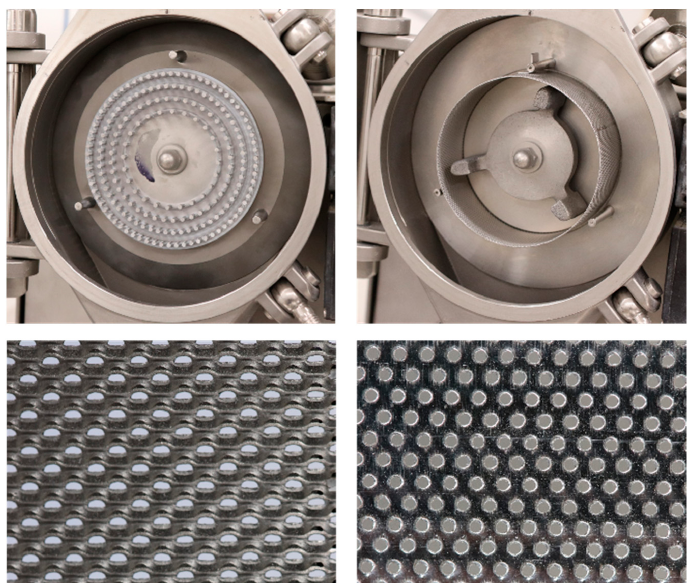
Figure 1. Pin mill rotor ( top left ) and hammer mill rotor ( top right ) used in experiments. Screen designs: rasp ( bottom left ) and smooth ‐ contoured ( bottom right ). Three rotor frequencies were used: 64, 185, and 303 s − 1 in hammer milling and 64, 202,